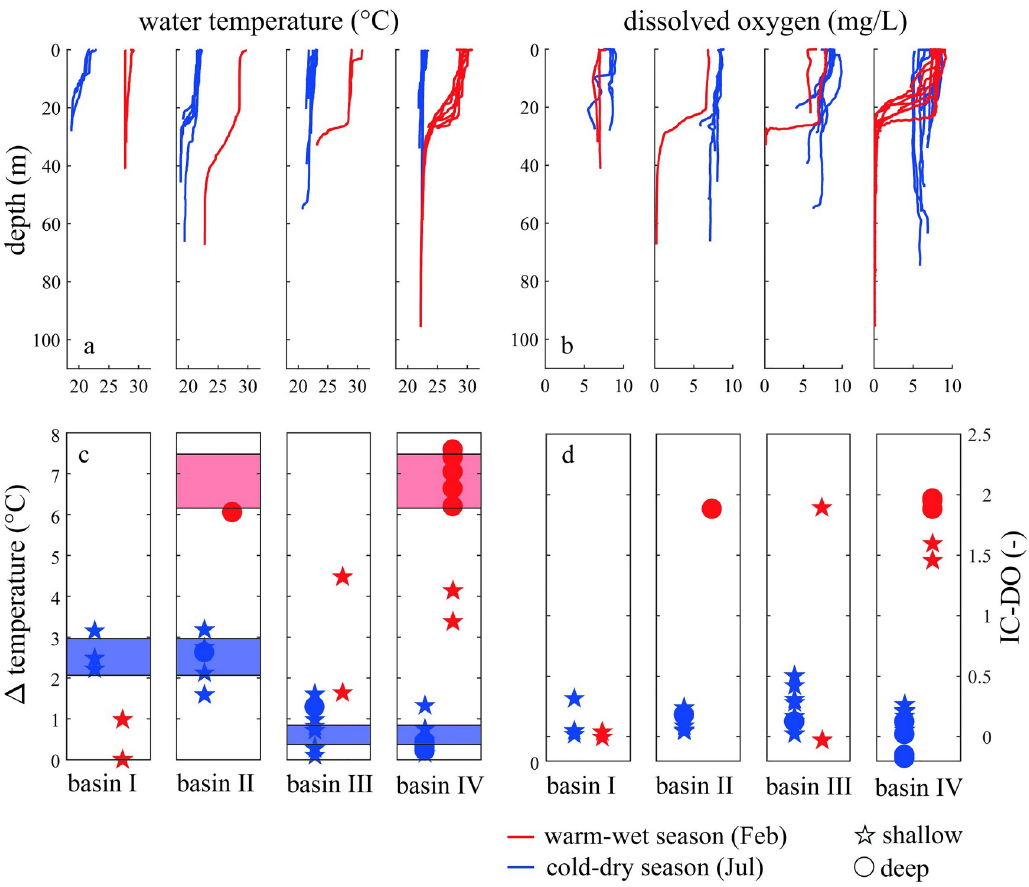
Fig 3. Thermal and chemical stratification in the four sub-basins of Lake Kariba for February (red) and July (blue). Observed vertical profiles of water temperature (a) and dissolved oxygen (b) in the four sub-basins of Lake Kariba. The strength of the stratification is shown as the temperature difference between the top and bottom 5 m in each profile (c). Strength of the oxygen stratification (d). Circles in panels c and d represent deep parts of the lake and stars represent shallow parts. The threshold between shallow and deep is 50 meters. Blue areas represent the 95% confidence intervals of the mean stratification strength during the cold-dry season in the first two and second two sub-basins, respectively. The red area represents the confidence intervals of the mean stratification strength during the warm-wet season for deep